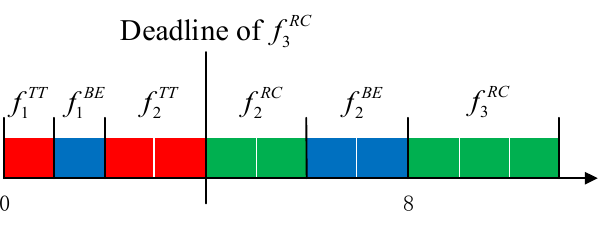
Figure 4. Example of shaping in ascending order of traffic load.